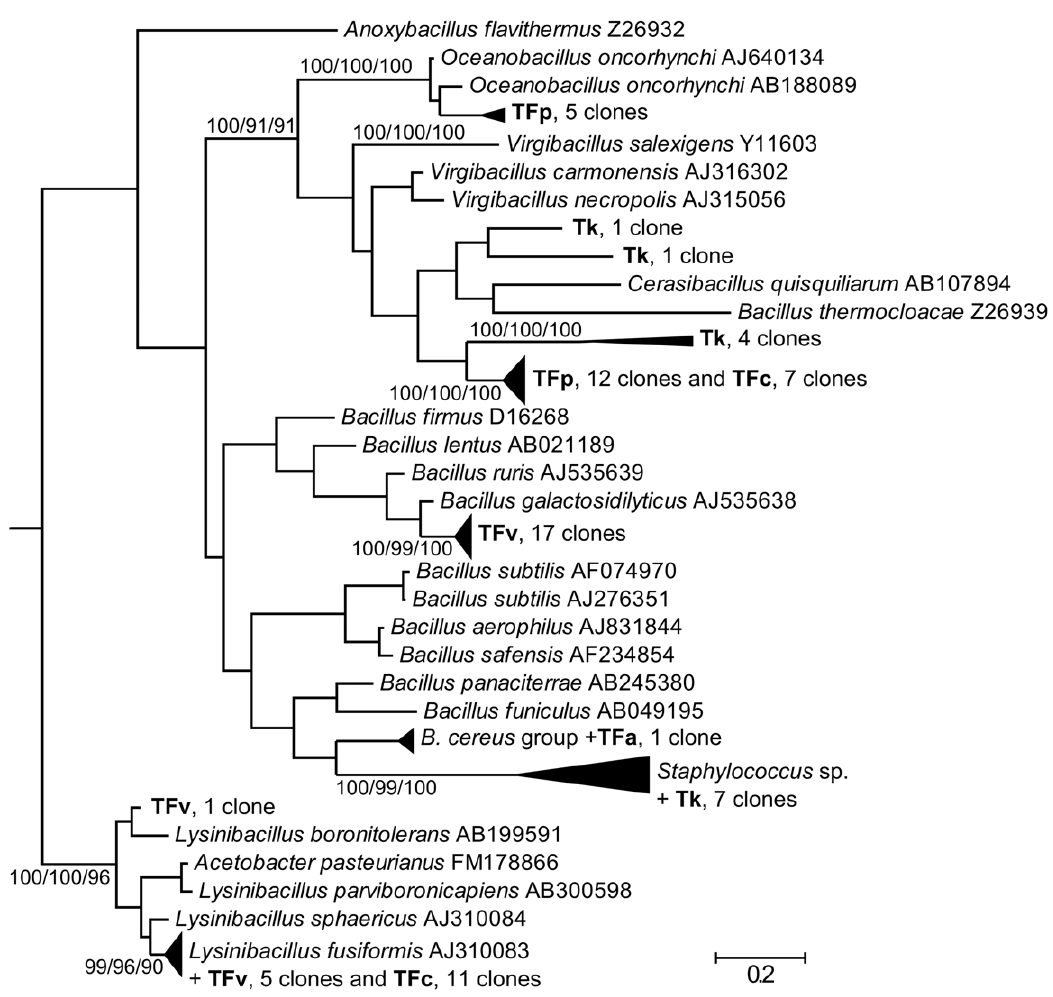
Figure 2. Phylogenetic analysis of clones and isolates belonging to Bacillales together with their closest neighbors available in RDP database. Phylogeny was inferred by Bayesian analysis of 16 S rRNA gene sequences of 69 clones from Tyrophagus putrescentiae grown on the tested diets (Tk - rearing diet, TFa - Fusarium avenaceum , TFc - F. culmorum , TFp - F. poae and TFv - F. verticillioides ) and 39 selected type-strain sequences from the genera Bacillus and Staphylococcus . Branch lengths correspond to mean posterior estimates of evolutionary distances (scale bar, 0.2). Branch labels indicate the Bayesian posterior probability and for selected branches also supporting bootstrap values from maximum-likelihood and neighbor-joining analyses. The phylograms were outgrouped using the E. coli sequence